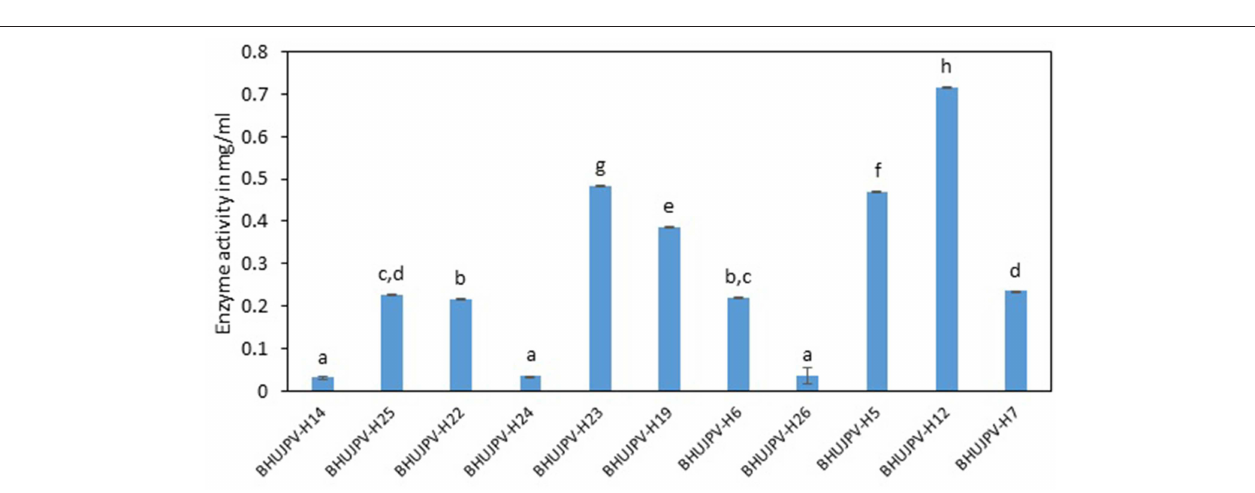
FIGURE 6 | Enzyme activity on sugarcane bagasse (Sugars released on degrading wheat straw). Values are the mean ± SE (standard error). Mean values in each bar with the same alphabet superscript(s) do not differ significantly, but different alphabet superscript is showed significantly different between each treatment by Duncan post hoc test ( p ≤